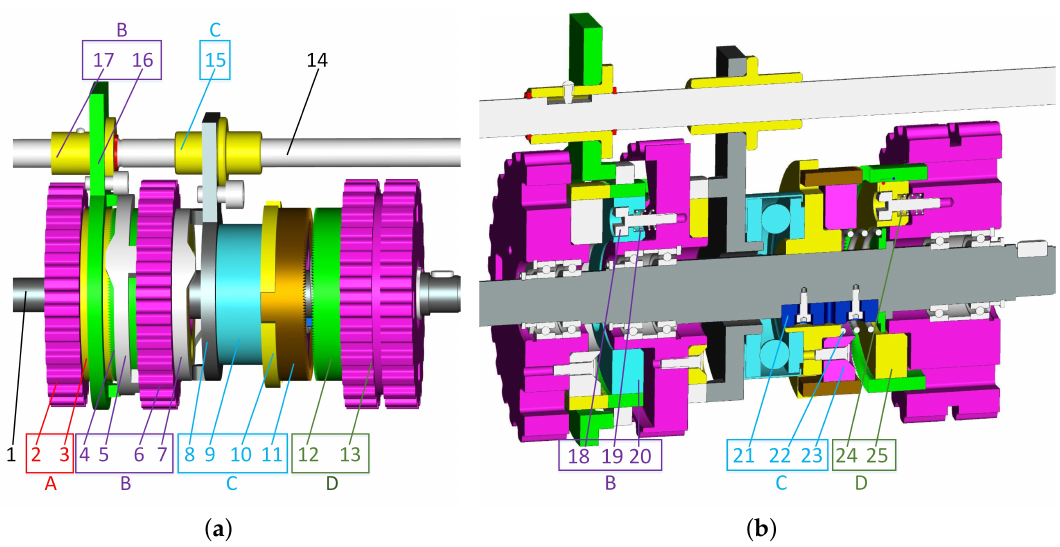
Figure 1. The structure of the power switch unit (PSU) in “switched off” status. ( a ) The PSU structure in “switched off” status. ( b ) The PSU cross-sectional view is in “switched off” status. Part 1 is the transmission shaft used for transmitting the power to the current joint, and all the other parts of the PSU are assembled on it. Part 2 (SJPS) is the slave pulley used for transmitting the rotation of switch motor. Part 3 is the slave clutch used for switching power among joints. Part 4 is the master clutch used for switching power among joints; it can slide along the axis direction of Part 7. Part 5 (SJC) is the cam used for switching power among joints; it is fixed with Part 4, so it can slide along the axis direction of Part 7 together with Part 4. Part 6 (SJPM) is the master pulley used for switching power among joints. Part 7 (SPC) is the switch power cam used for transmitting power to the current joint. Part 8 (SPF) is the switch power cam follower of Part 7; it can slide along the direction of the axis of Part 1. Part 9 is thrust bearing. Part 10 is the slider. Part 11 is the master clutch used to transmit power to the current joint. Part 12 is the slave clutch used to transmit power to the current joint. Part 13 (SPP) is the power pulley. Part 14 is the guide rod. Part 15 is the guide sleeve of Part 8. Part 16 (SJF) is the cam follower for Part 5. Part 17 is the sleeve used for positioning Part